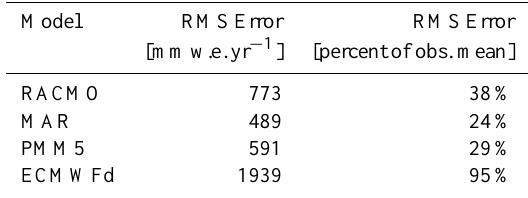
Table 6. Difference between modelled and observed SMB below 1500m